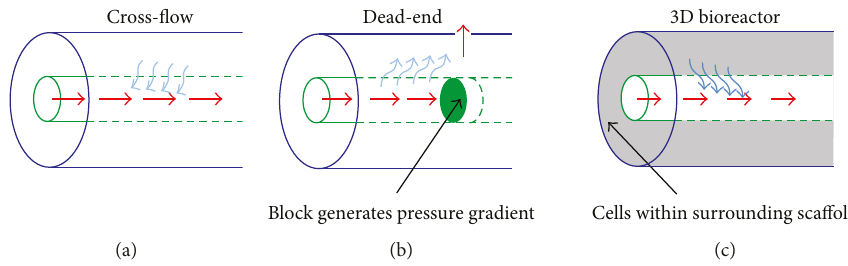
Figure 1: Schematics for hollow fi bre cell fi ltration experiments. (a) Cross- fl ow fi ltration: cells are inoculated within the abluminal, shell region, fi ltered through the fi bre into the perfused lumen and are collected at the fi bre e ffl uent. (b) Dead-end fi ltration: a solution of cells is perfused into fi bre lumens, which are blocked at the exit with a resin solution so cells must pass through the fi bre into the shell and are collected at an opening in the shell. (c) HFBR culture: cells are inoculated into a 3D porous sca ff old formed around the fi bre, which is perfused for 21 days. Red, blue, and black arrows indicate fl ow direction, cell movement, and commented